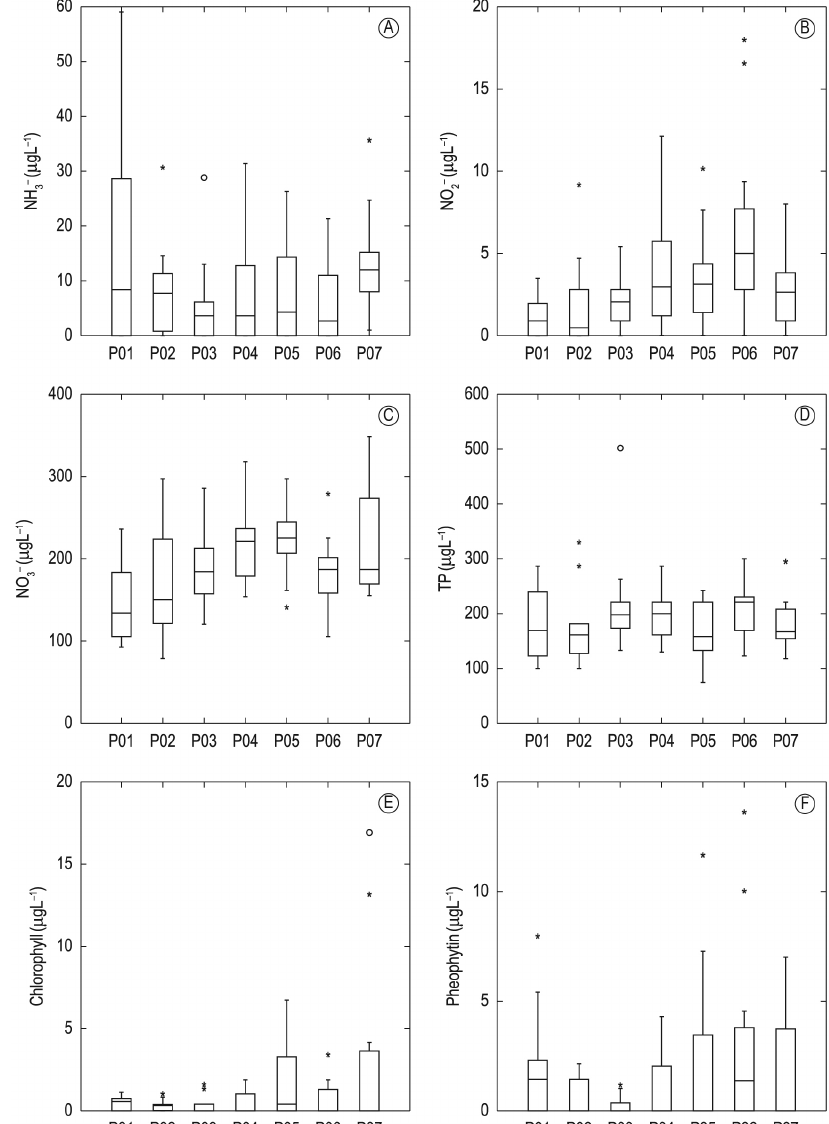
Figure 4. Concentration of dissolved inorganic nutrients (A – ammonium, B –nitrite, C –nitrate, D – total dissolved reactive phosphorus) and photosynthetic pigments (E - chlorophyll a; and F - Pheophytin) along the brine circuit in Salina Unidos. (*Extreme values;